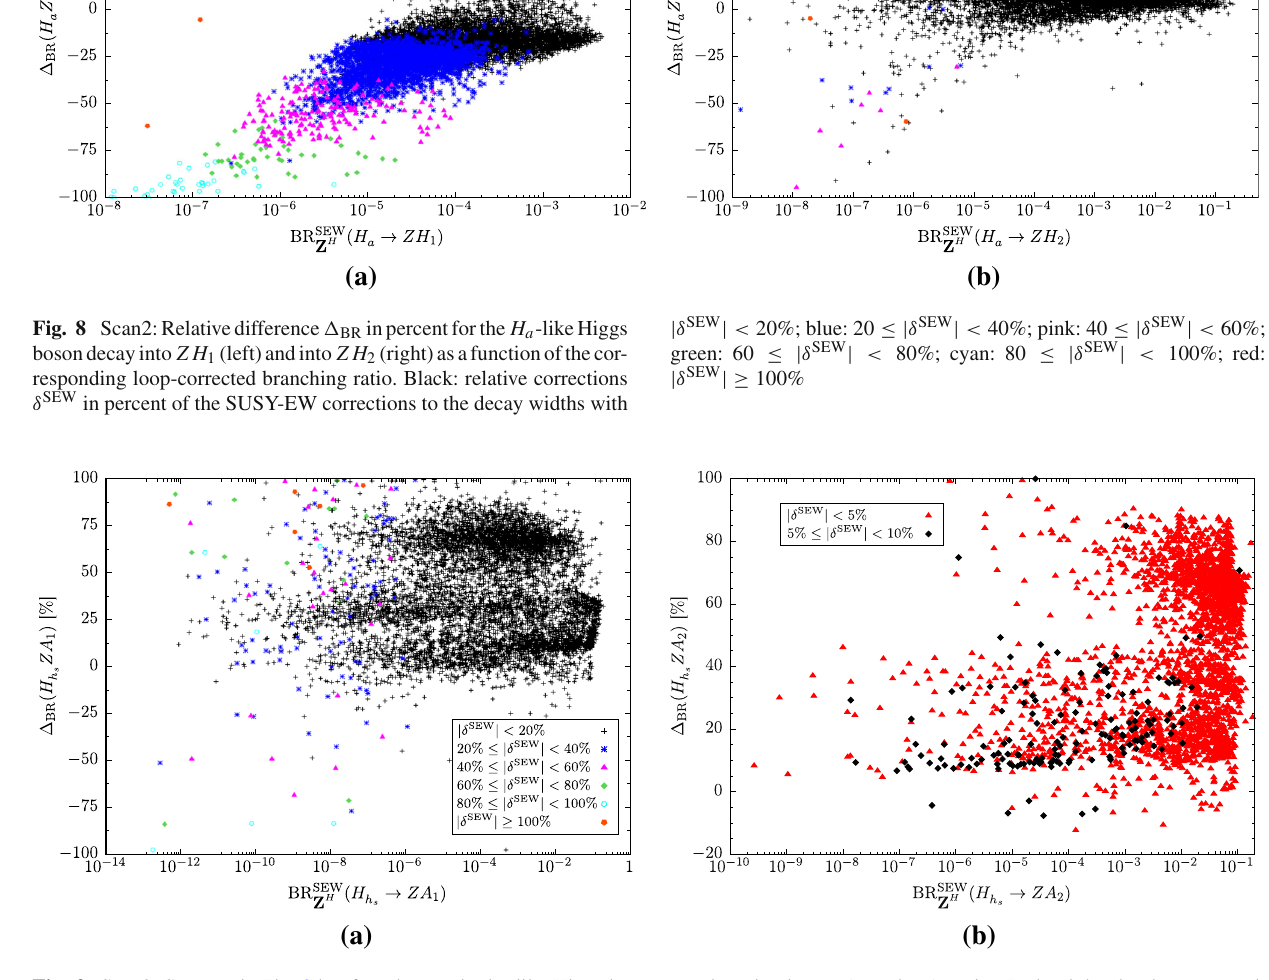
Fig. 9 Scan2: Same as in Fig. 8 but for a heavy singlet-like Higgs boson H h | δ SEW | < 5%; black: 5 ≤ | δ SEW | < 10% neutralinos and i = 1 , 2 for the charginos, never exceeds 46